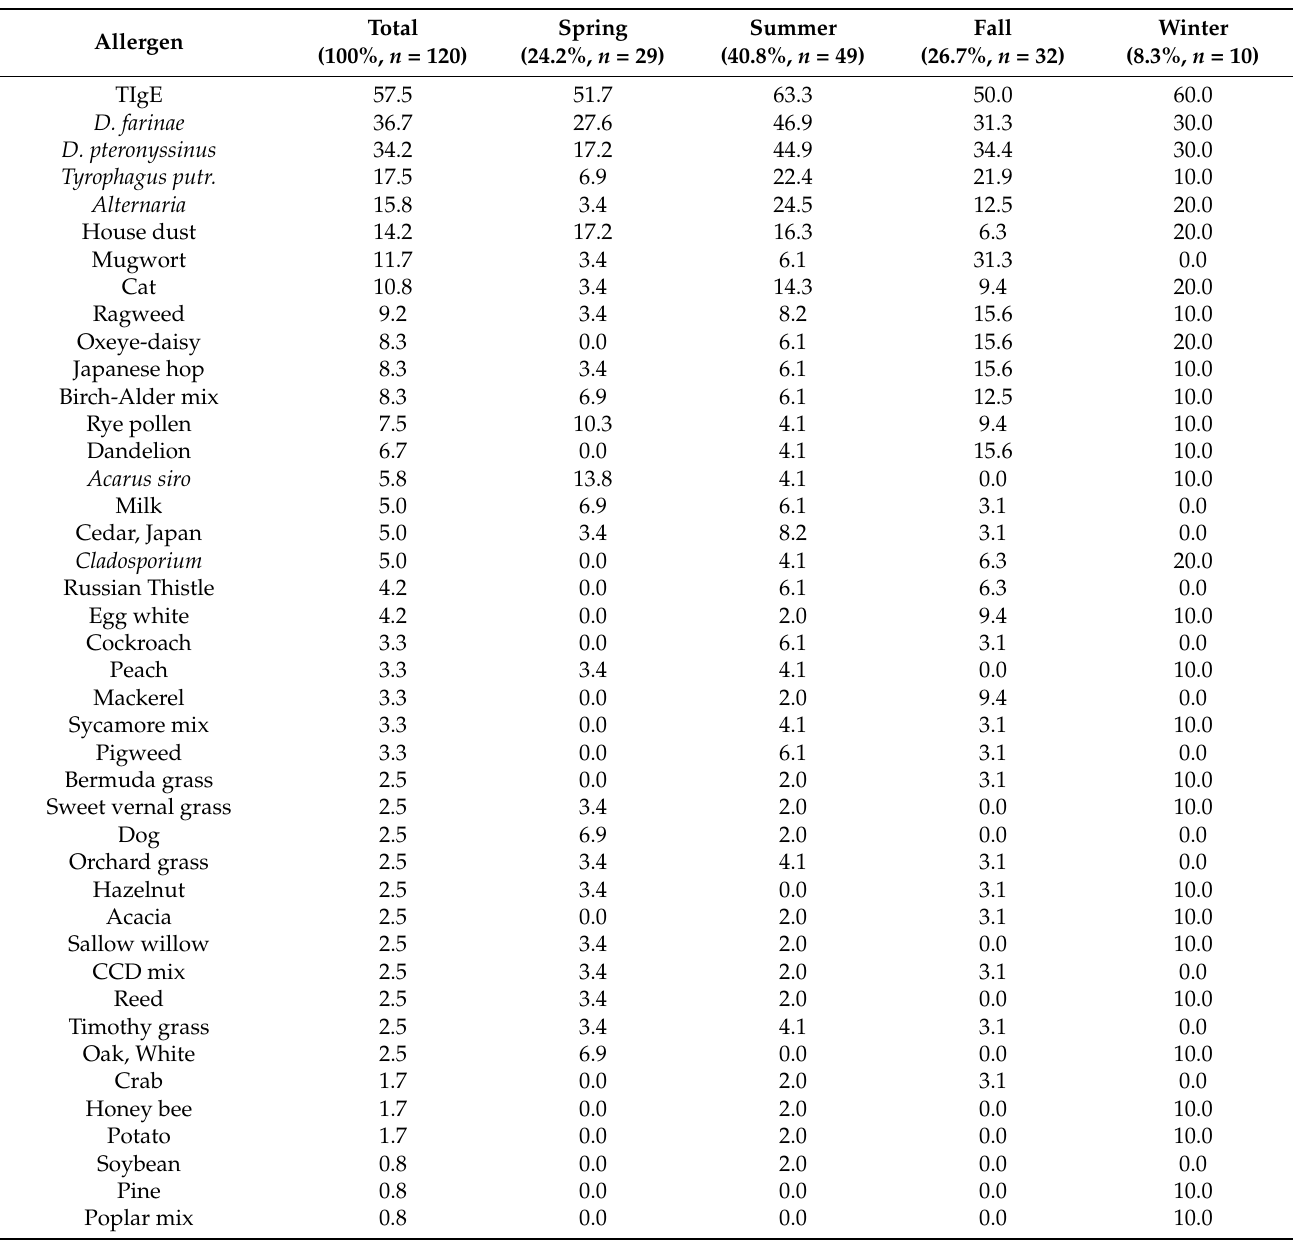
Table 1. Positive rate of each allergen-specific immunoglobulin E (IgE) detected by multiple allergen simultaneous test- immunoblot assay subdivided by